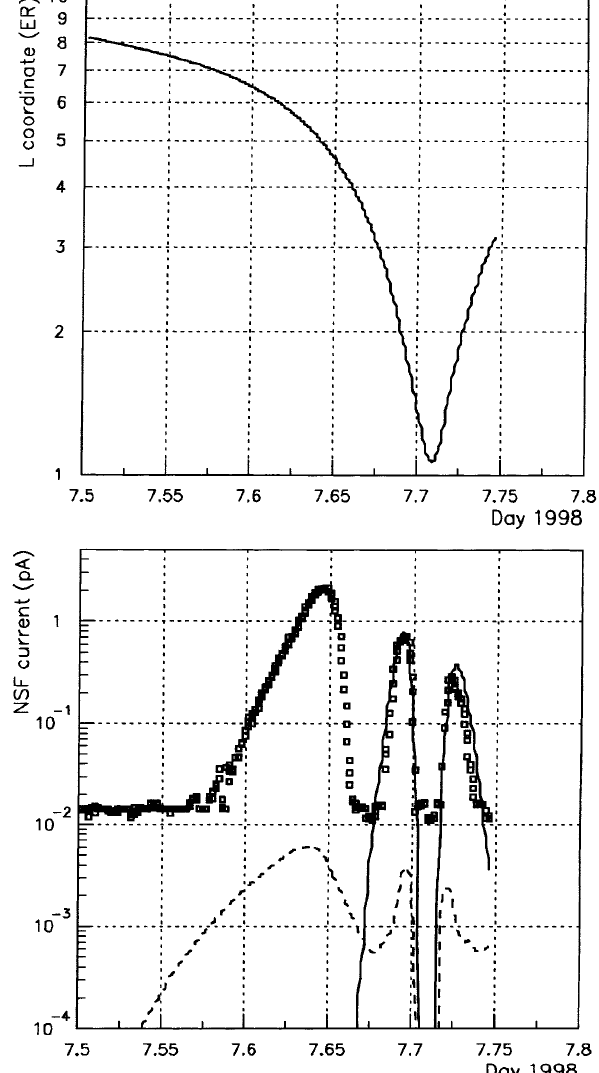
Fig. 2. Observed NSF output current ( square symbols ) versus time compared to the output current predicted using AP-8 and AE-8 models and the response of the scintillating fibres to protons and electrons. The upper panel gives the values of L at which currents were measured. The predicted proton contribution ( solid line ) is either in good agreement with the observed currents where L < 3 or slightly overestimated in the outer edge of the inner belt. The well known overestimation of the electron fluxes by the AE-8 model (Heck, 1992) should have resulted in an overestimated electron contribution to the NSF output current. But, due to the largely underestimated response of the scintillating fibres to electrons, the predicted electrons contribution ( dashed line ) is found to be a few orders of magnitude lower than the observed current in the outer belt where the electron contribution to the NSF current dominates. The predicted electron contribution to the NSF current at time 7.611 should be multiplied by a factor of about 30 in order to adjust its value to the observed one, but the same correction applied to the NSF current predicted for time 7.694 (in the inner belt) results in a relatively low electron contribution when compared